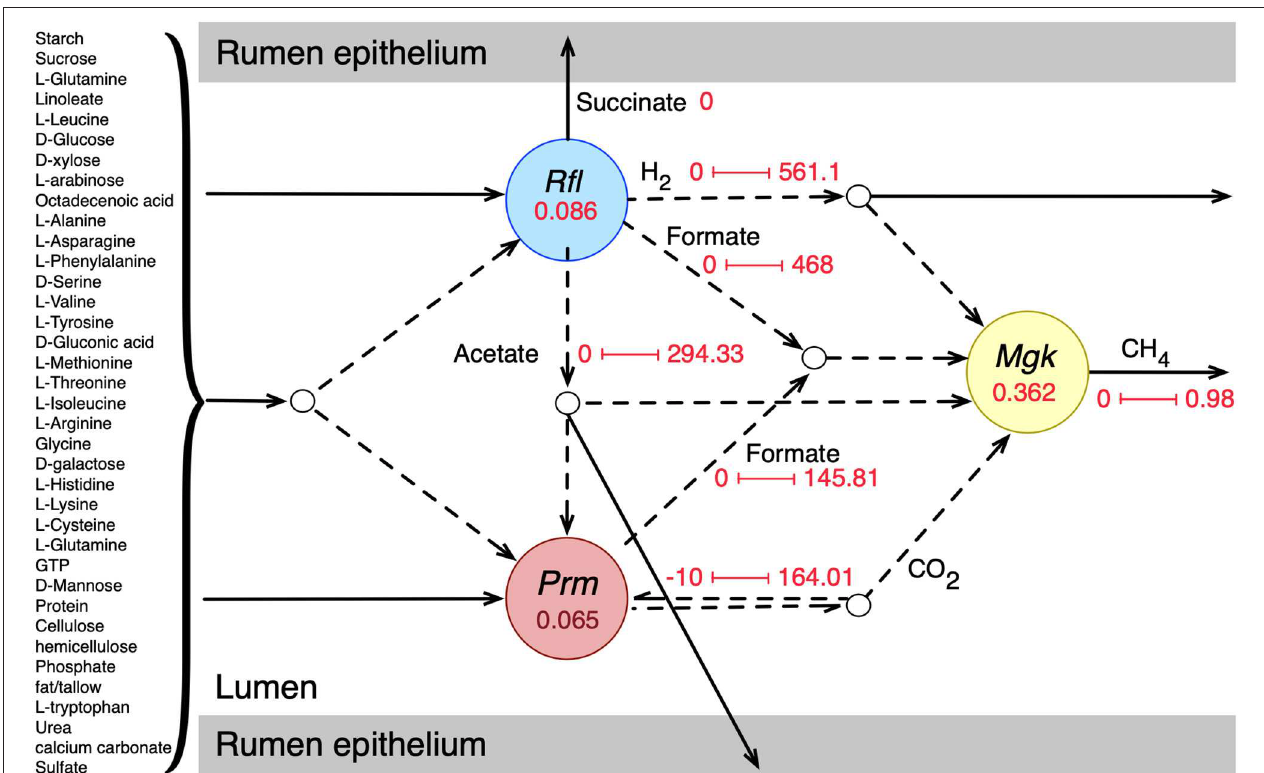
FIGURE 1 | Initial community simulation results showing the interactions between the bacterial and archaeal members. Rfl, Prm, and Mgk represent R. flavefaciens, P. ruminicola , and M. gottschalkii , respectively. The numbers inside the circles for each microbe represent the biomass flux (growth rate) of the respective microbe (hr − 1 ). The arrows represent metabolic fluxes in mmol/gDCW.hr (dashes for inter-species/shared metabolites and solids for transfer to and from the rumen epithelium). The numbers along the arrows represent the minimum and maximum flux values.